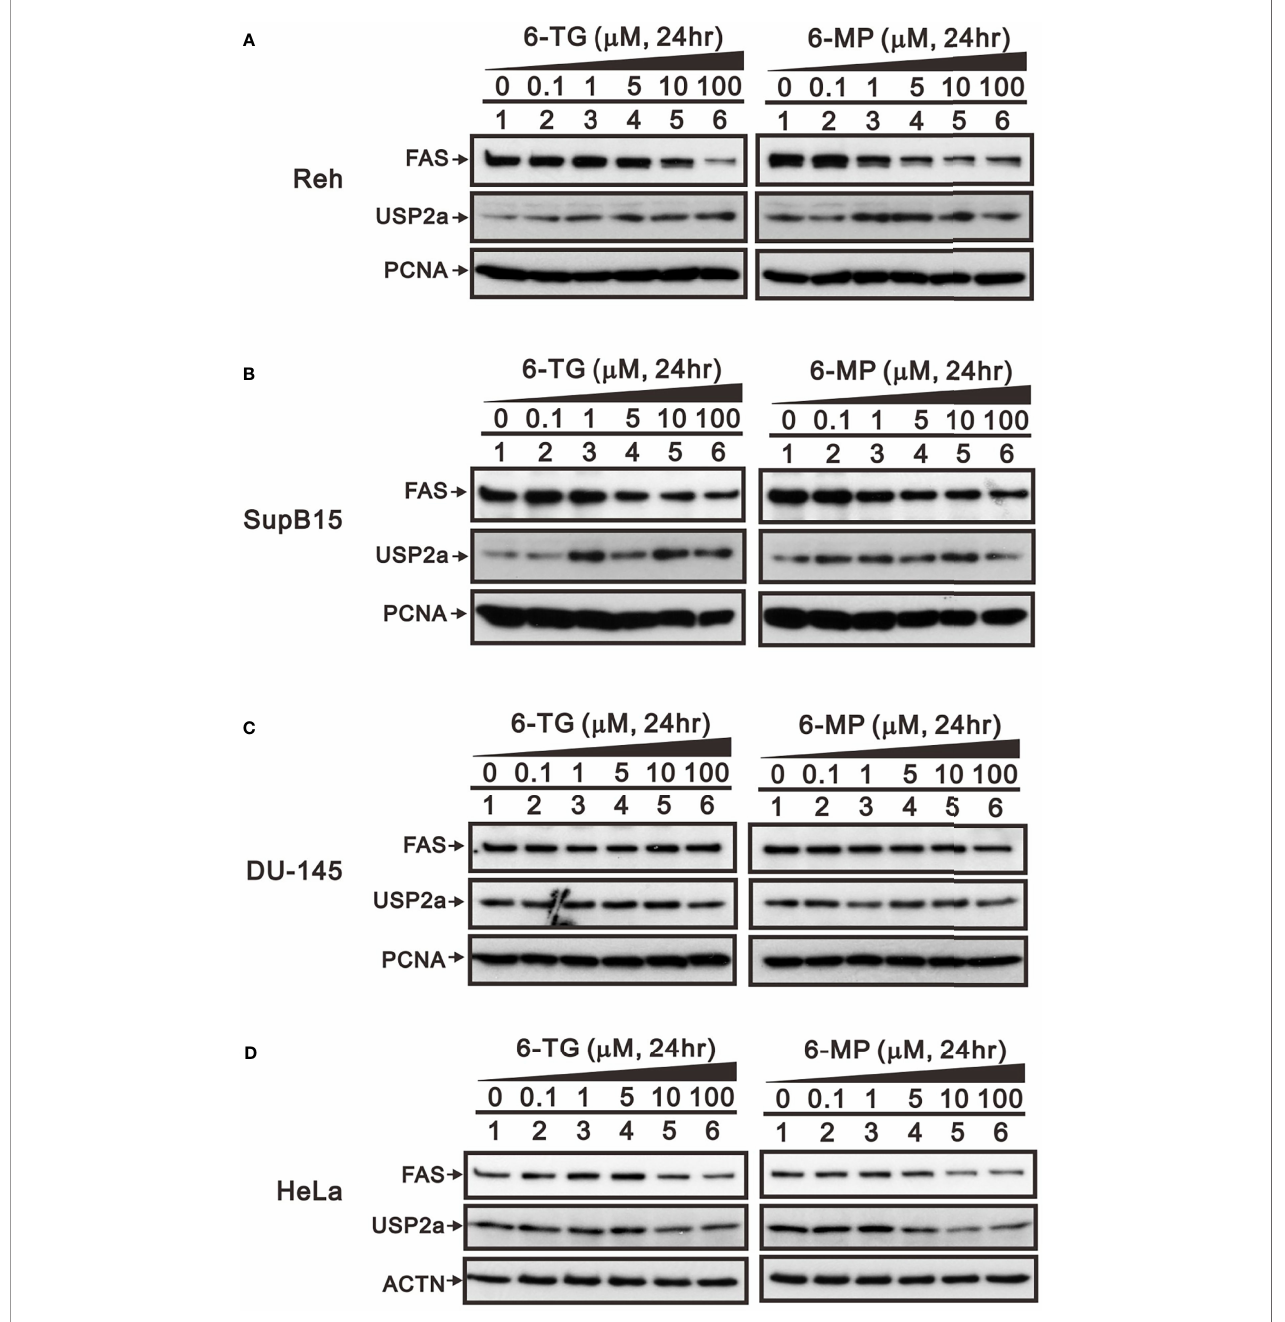
FIGURE 4 | Effects of 6-TG and 6-MP on expression of FAS protein in several cell types. (A) Reh, (B) SupB15, (C) DU-145, and (D) HeLa cells were treated for 24 h with the indicated concentrations of 6 ‐ TG or 6-MP, after which cell lysates were subjected to Western blotting analysis with antibodies against FAS and USP2a. PCNA or ACTN are protein loading